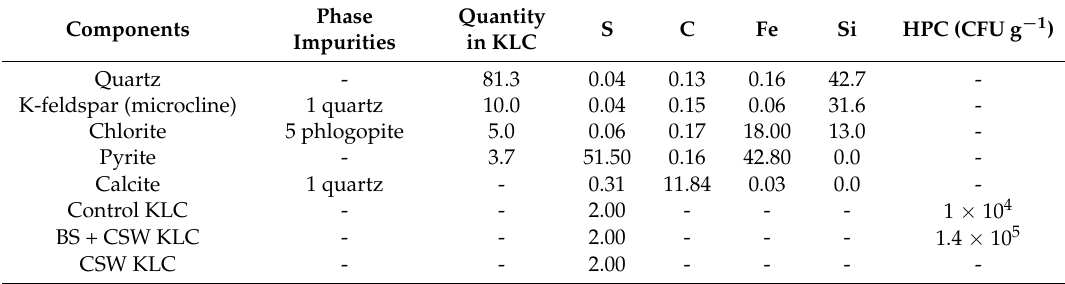
Table 1. Kinetic leach column (KLC) standard mineral and microbiological compositions at time zero (in wt % unless stated otherwise). Heterotrophic plate count (HPC); colony forming units (CFU); calcite-saturated water column (CSW); biosolids-treated column (BS + CSW). Phase Quantity Components S Impurities in KLC Quartz -